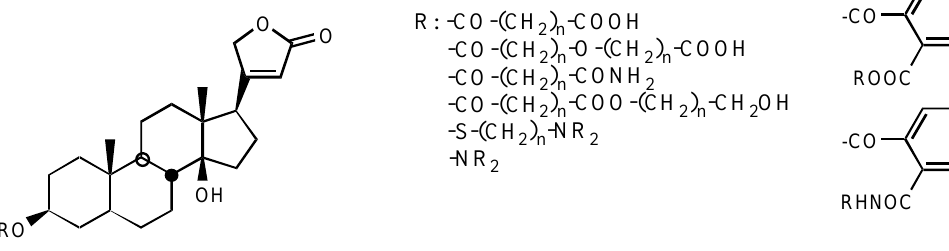
Figure 17. Structure of some derivatives bearing different moieties at